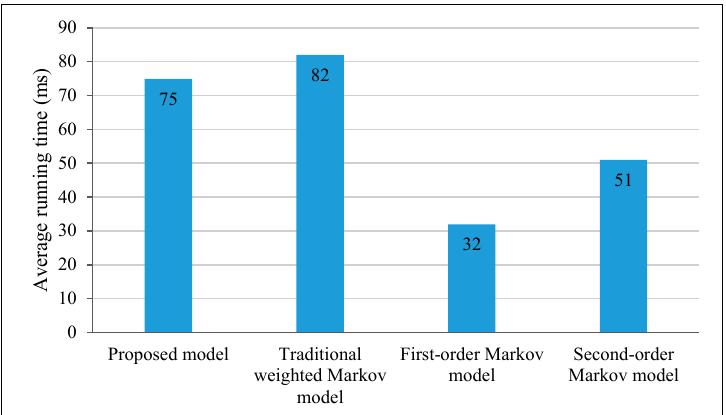
Figure 7. Prediction results of the weighted Markov model based on different user classifications.